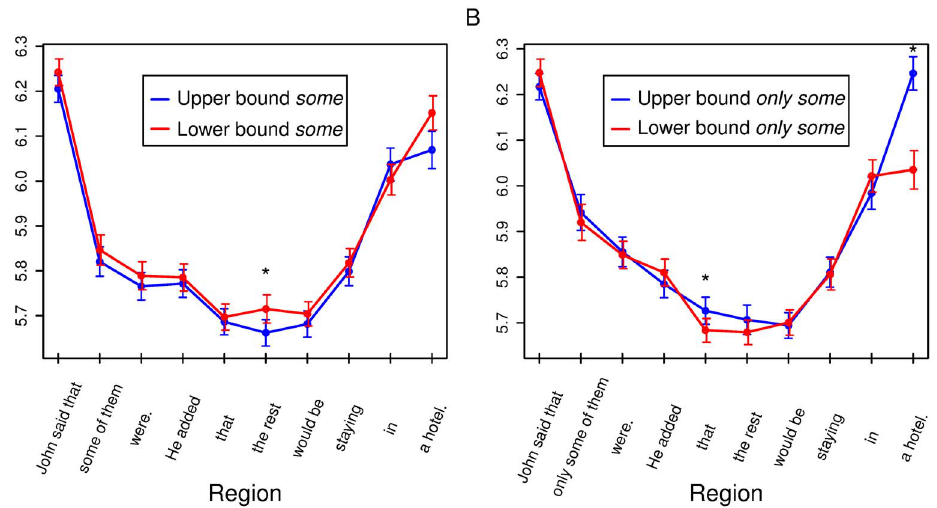
Figure 1. Segment-by-segment reading times. Reading times by region for the last two sentences in some vignettes (panel A) and only some vignettes (panel B). Regions showing a significant effect of boundedness for a given quantifier type are indicated with an asterisk. Error bars represent